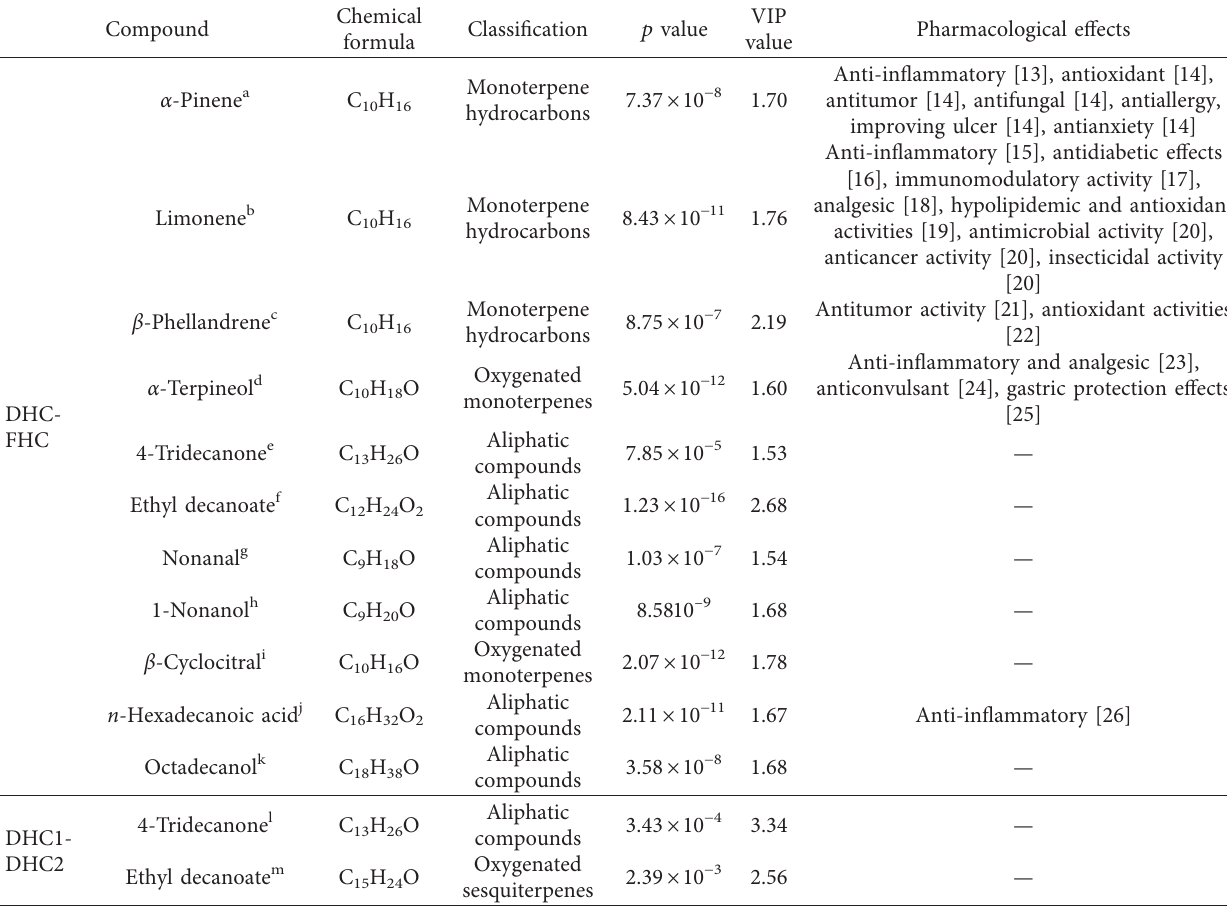
Figure 4: PCA analysis and OPLS-DA analysis of DHC and FHC and their two harvest seasons. PCA score plot for DHC and FHC (a). OPLS-DA score plot and the corresponding validation plots based on 200 times permutation tests of the OPLS-DA model for DHC and FHC (b, c), for DHC1 and DHC2 (d, e), and for FHC1 and FHC2 (f, g). Table 2: Pharmacological effects of chemical markers identified for DHC and FHC, DHC1 and DHC2, and FHC1 and FHC2 from the OPLS-DA validation